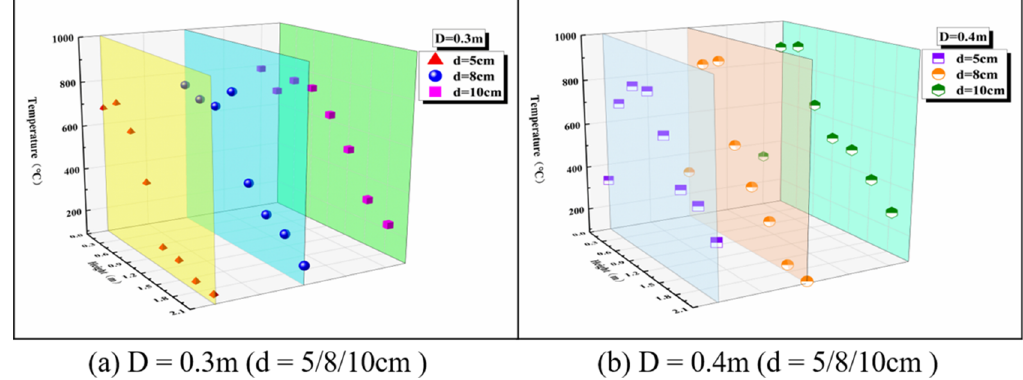
Figure 5. Relationship between axial flame plume temperature and axial position under various conditions.